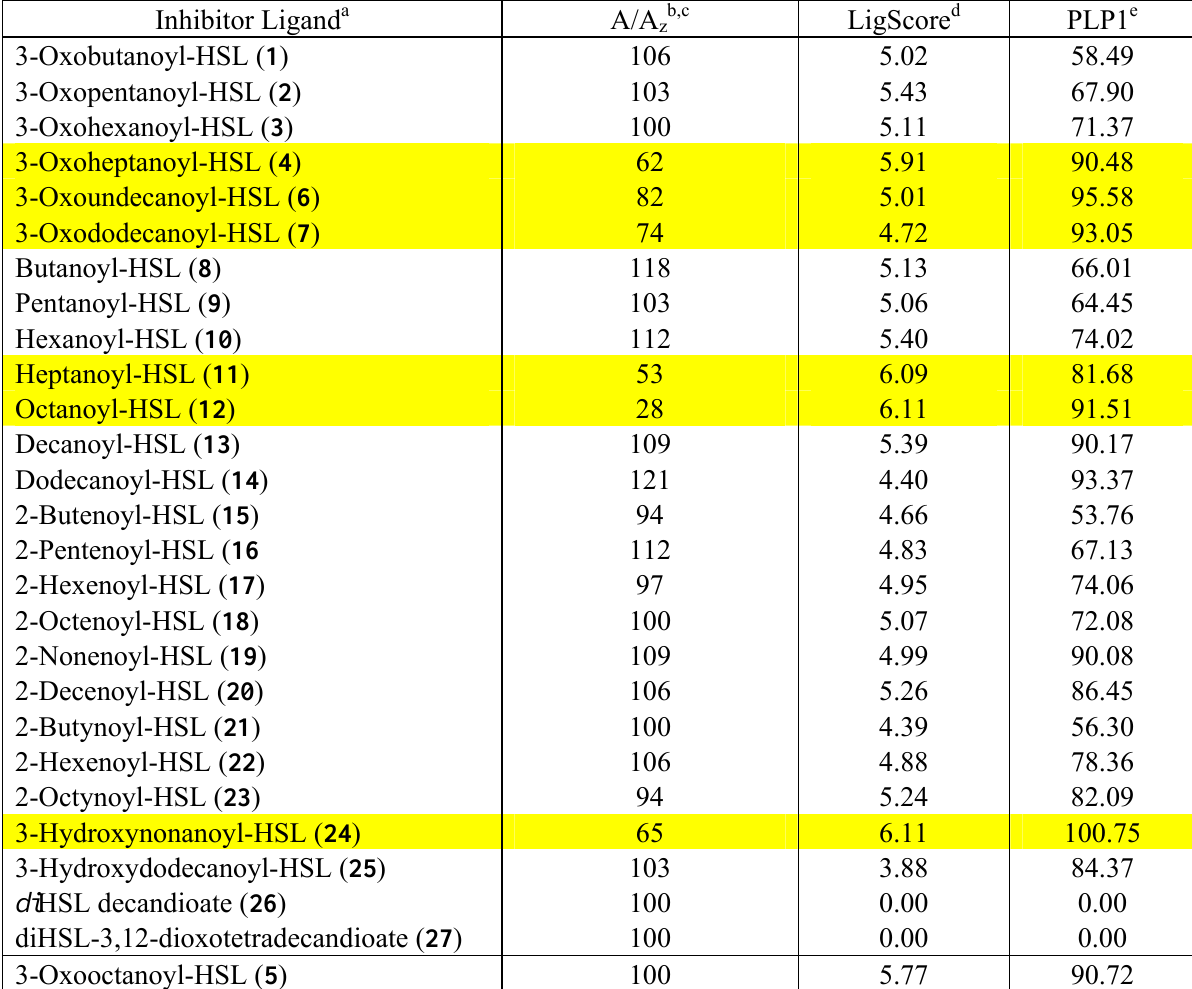
a Refer to Figure 4. b Measure of competitive inhibition of β -galactosidase activity in A. tumefaciens strain with 100 nM concentration of the ligand in the presence of 100 nM of the native autoinducer, 3-oxo-C referenced to A z , activity without the presence of inhibitor ligand. d,e Scoring function references [20, 21].